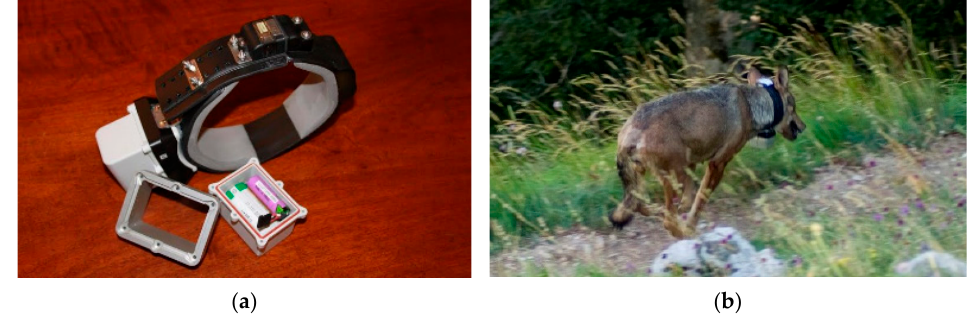
Figure 3. GPS tracking collar (Lotek Wireless Inc.): ( a ) GPS collar before being applied to the wolf, ( b ) Carlina wolf equipped with the GPS collar and photographed immediately after the release.